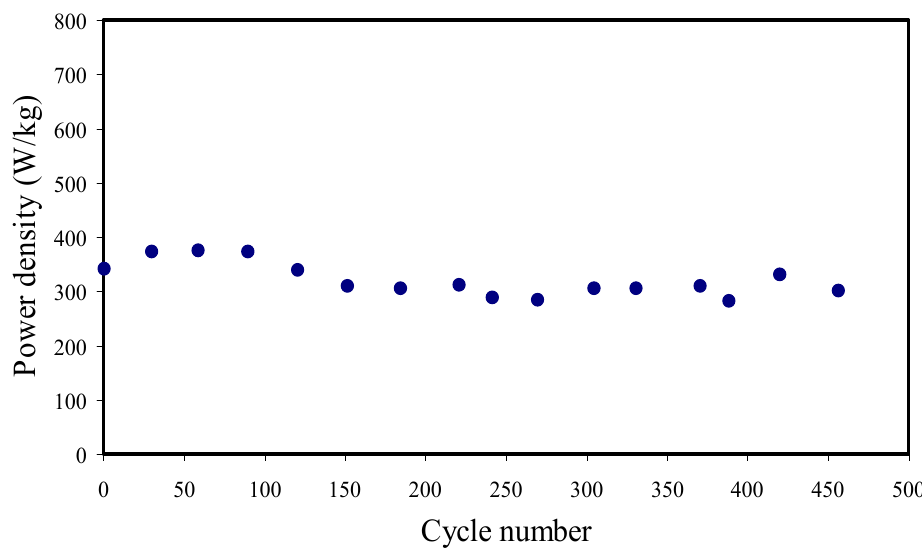
Figure 14. Energy density of the EDLC device for the 450 cycles at RT.